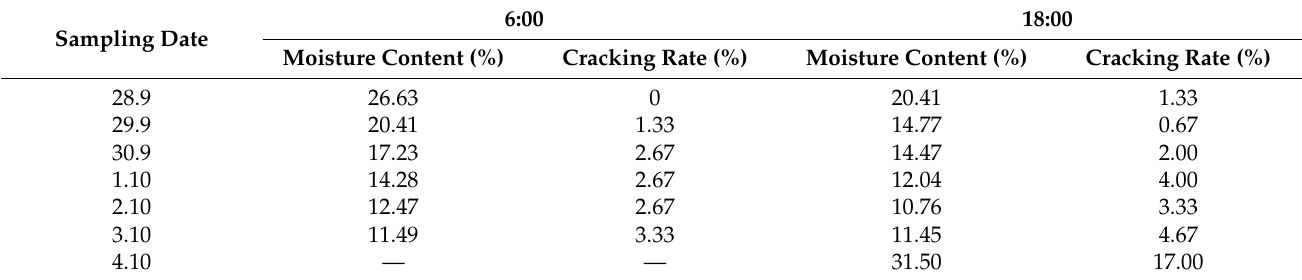
Table 6. Moisture content and cracking rate of grains in a baling and drying test.